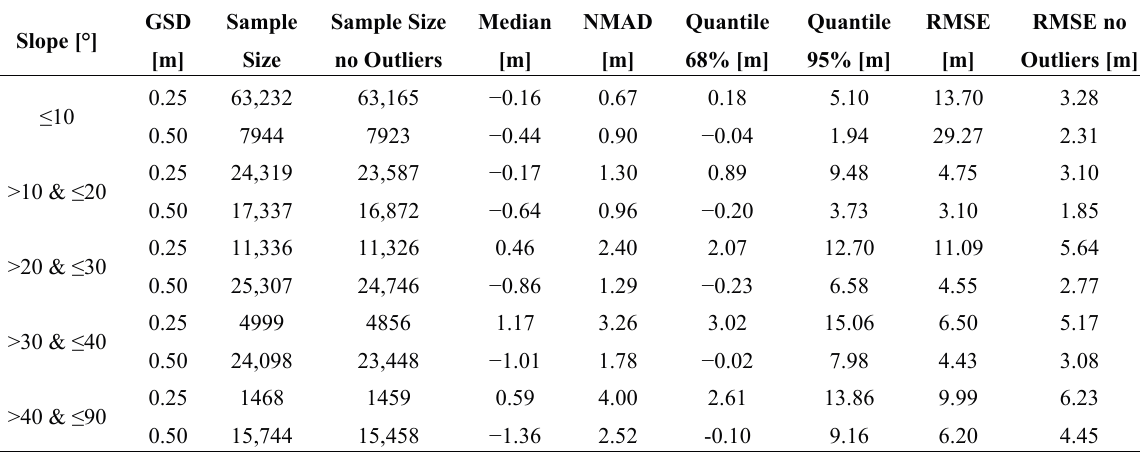
Table 5. Vertical agreement measurements of the digital surface model based on stereo measurements covering five slope classes. Differences were calculated by subtracting the elevation values of the stereo measurements from the values of the digital surface model. A threshold value of ±3 × RMSE was applied for outlier exclusion.